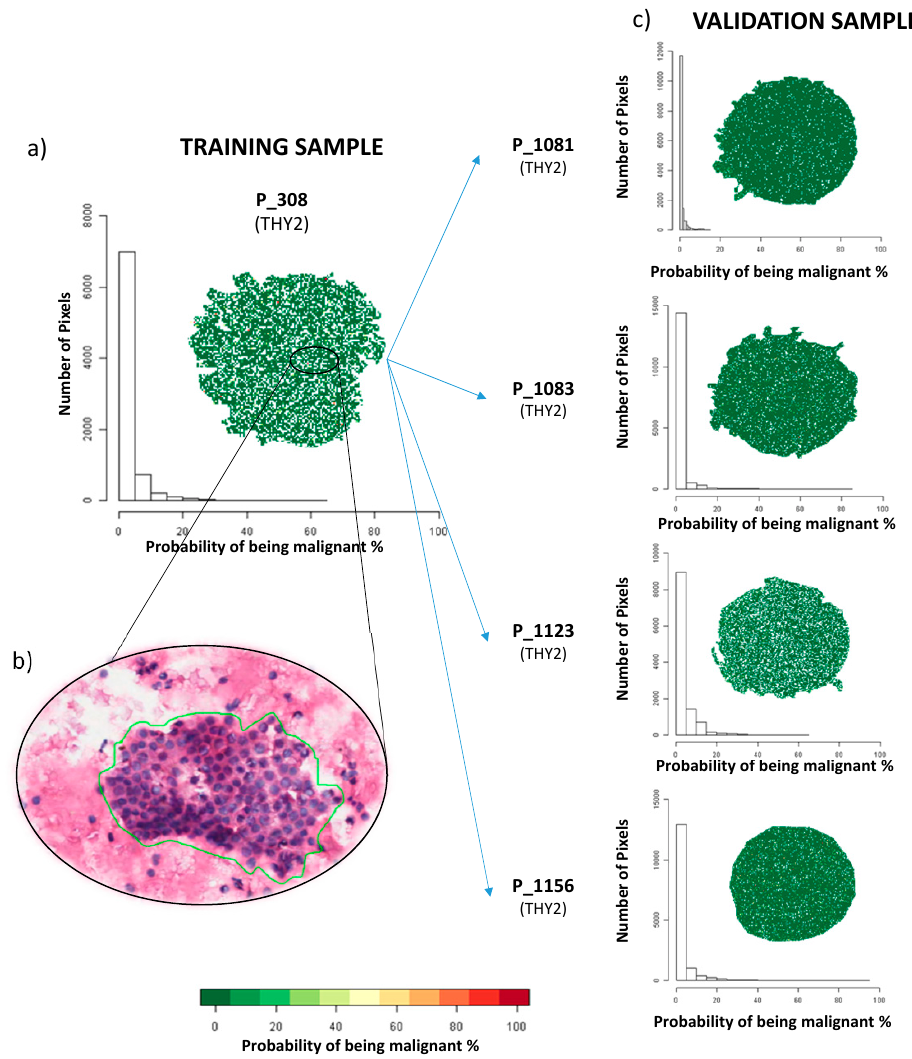
Figure 1. Examples of pixel-by-pixel images and distributions of the probabilities of being malign in the training and validation set of benign Thy2 nodules. ( a ) imzML MALDI-MSI data of the Thy2 P_308 in the training sample; ( b ) haematoxylin and eosin (H&E) staining of P_308; ( c ) validation of Thy2 samples using imzML MALDI-MSI